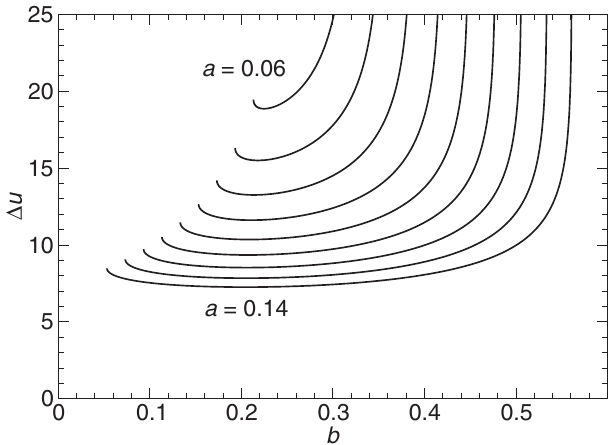
FIG. 15. Change in u as a function of b , for a evenly spaced between 0.06 and 0.14.